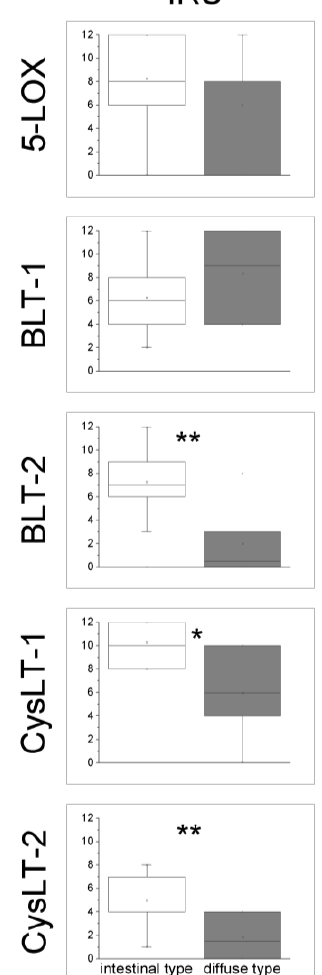
Figure 2. Immunohistochemical (IHC) expression scores of 5-LOX and LT-receptors in GC of intestinal and diffuse type. Values are presented as box plot graphics for IHC expression of 5-LOX and LT receptors BLT-1, BLT-2, CysLT-1, CysLT-2 in GC of intestinal and diffuse type, respectively. Each box plot shows the location of the median (marked line), mean (open square) and the 25 th and 75 th quartiles (inferior and superior limit of boxes). IRS: immunoreactive score. * denotes p < 0.05, ** denotes p < 0.01 (Mann-Whitney